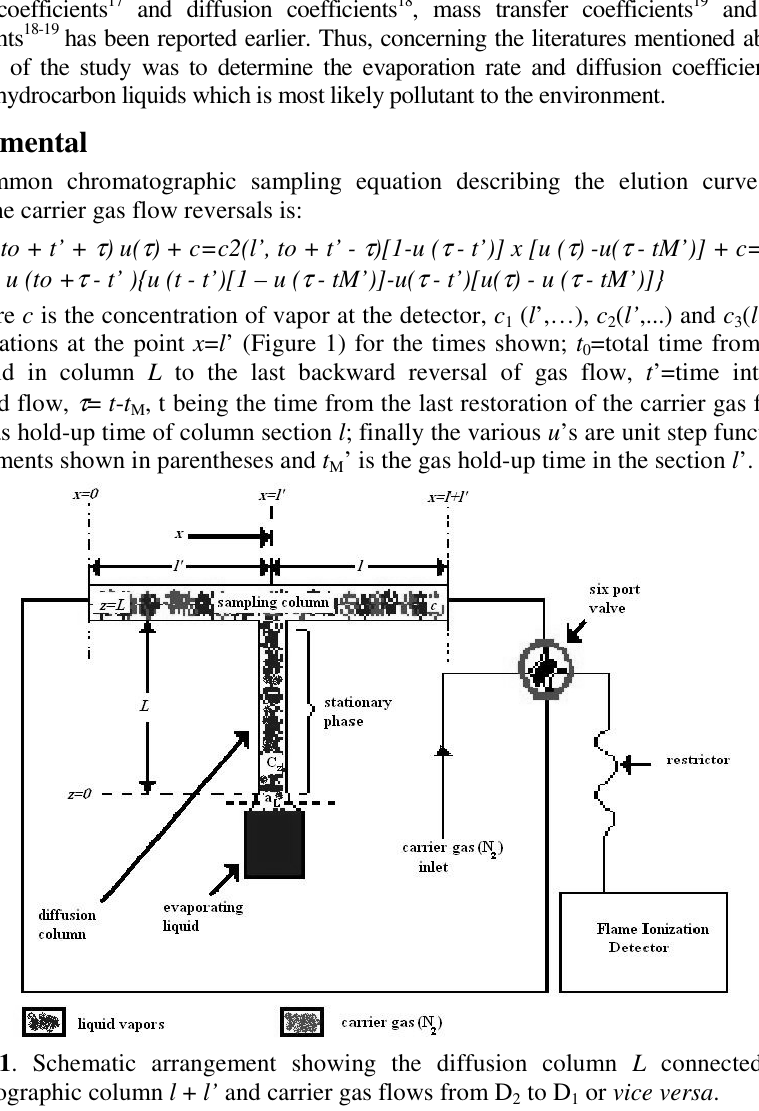
to D or vice versa 2 1